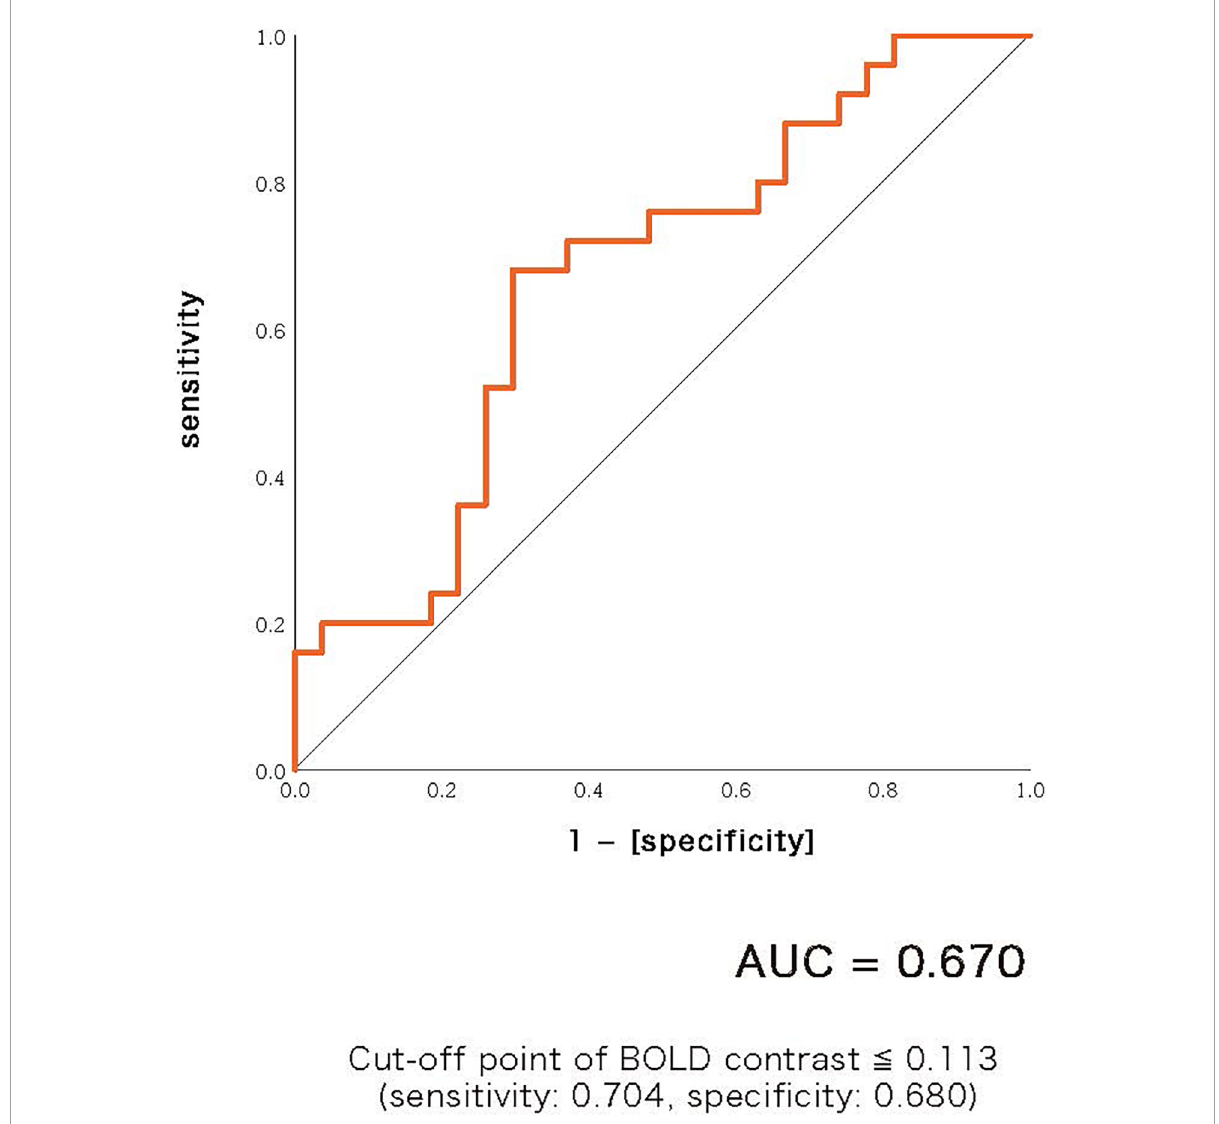
FIGURE4 Receiver operating characteristic (ROC) curve showing the ability to discriminate whether a person has bipolar disorder or not by the contrast values of ASSR-BOLD for 40-Hz stimuli in the right Brodmann areas 41 and 42. Area under the curve (AUC) was 0.67. Cut-off point was determined by Youden’s